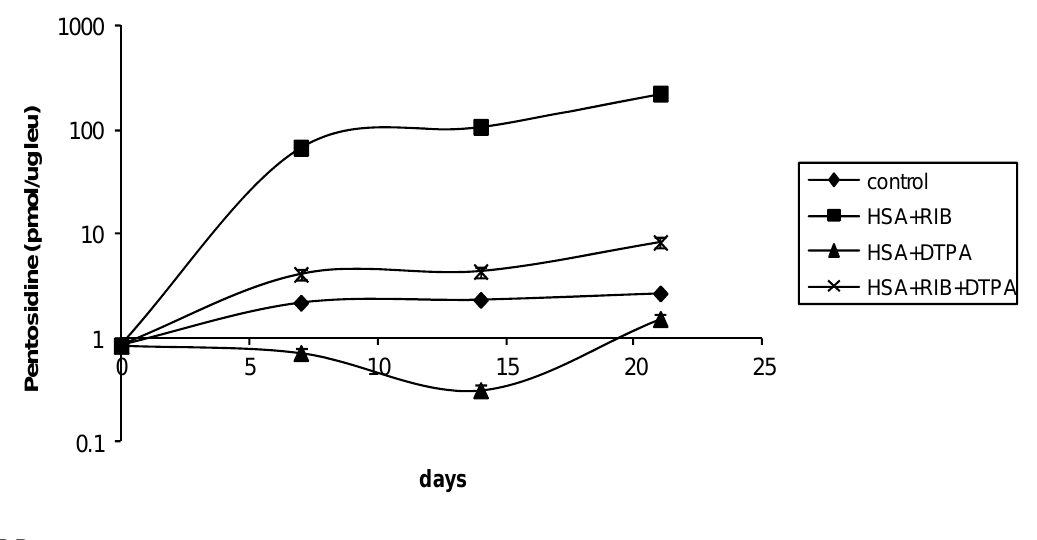
Figure 2. Effects of ribose, DTPA, and ribose + DTPA on pentosidine levels in HSA during 21 days of